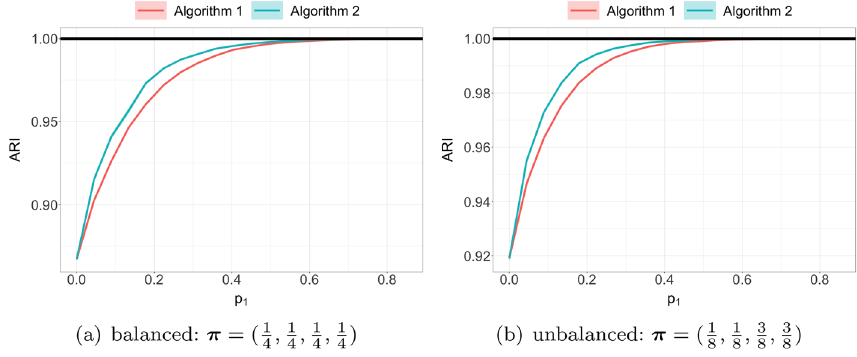
Fig. 5 Simulations for 4-block SBM parameterized by block connectivity probability matrix B as in Eq. (14) with initial sampling parameter p 0